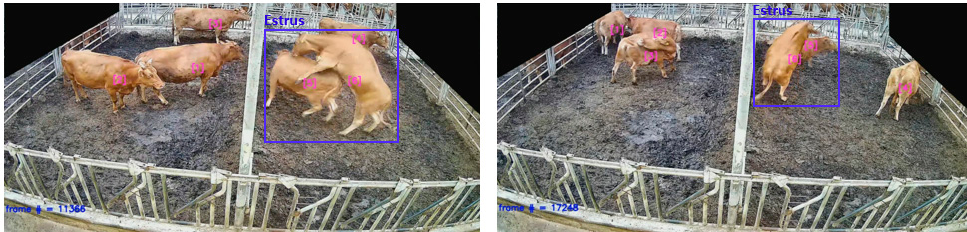
Figure 9. Operation of ARM: collection of activity data from Hanwoo and detection of mounting activities.